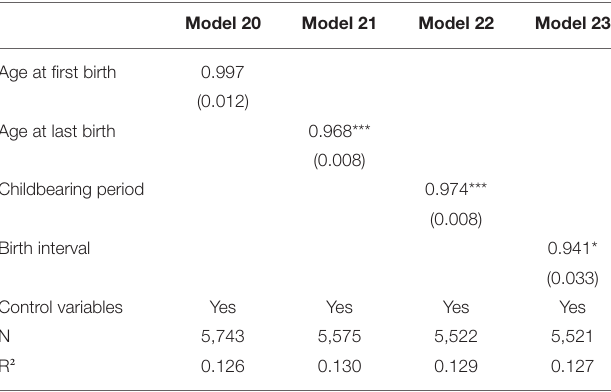
TABLE 9 | Estimates of the effect of other reproductive behaviors on diabetes in elderly women.